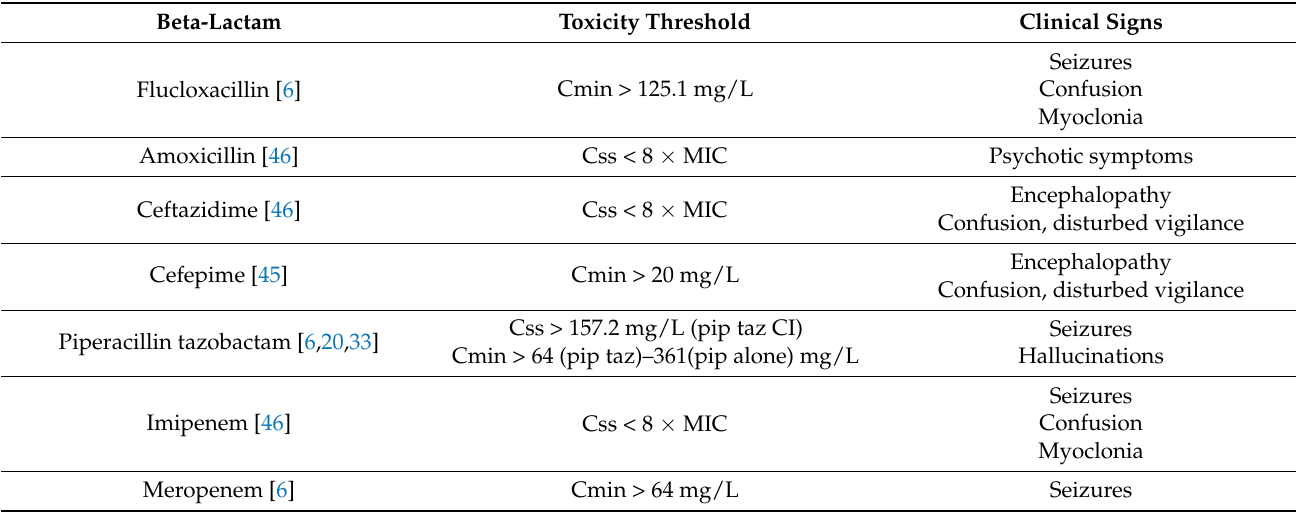
Table 2. Suggested beta-lactam toxicity thresholds and main clinical manifestations of neurotoxicity according to the beta-lactam agent